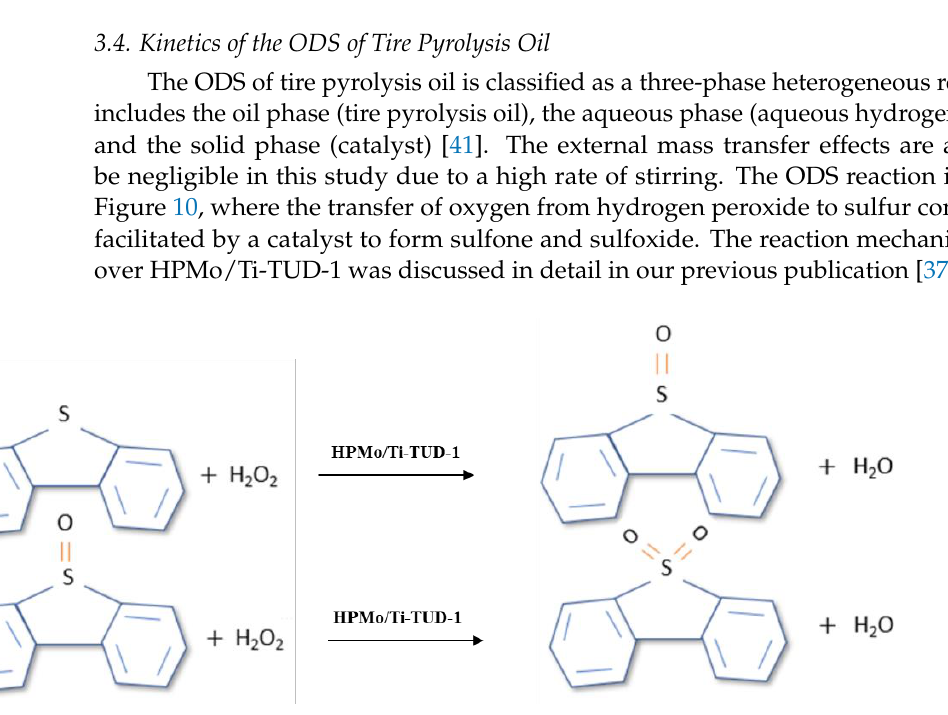
Figure 10. Oxidation reaction pathway of sulfur compounds.